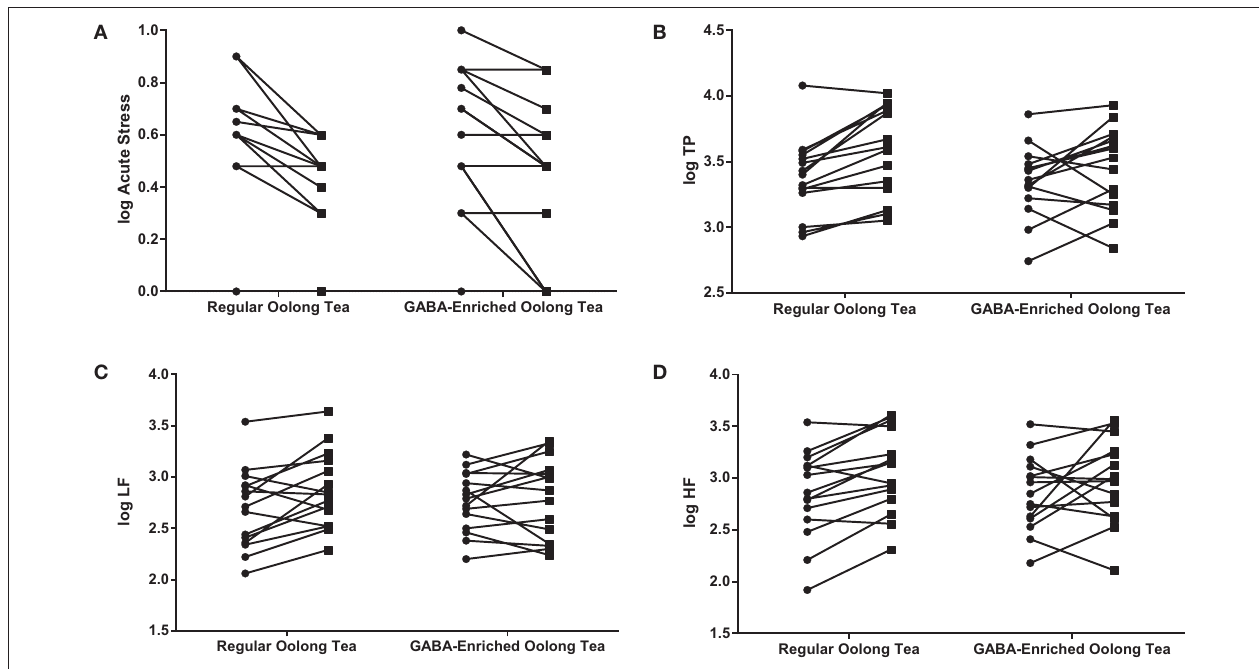
FIGURE 1 | Changes in (A) the acute stress score, (B) TP, (C) LF, and (D) HF in the GABA-enriched and regular oolong tea groups. Data are expressed as log values. Each line represents a separate participant. indicates pre-tea value; indicates post-tea